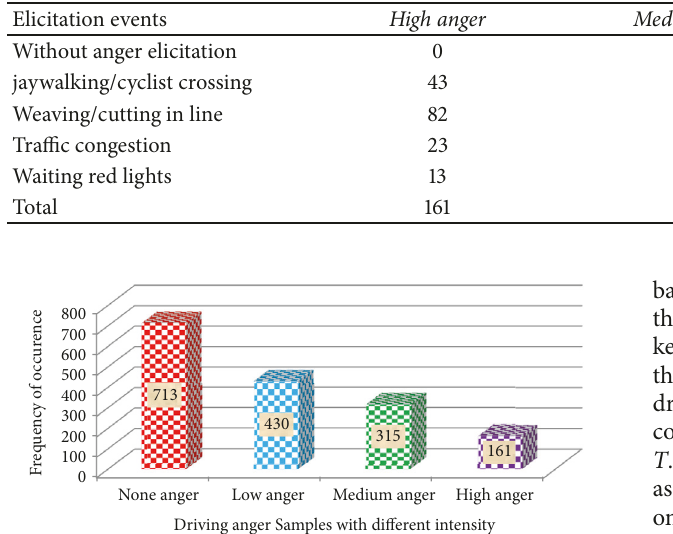
Table 3: The times of anger states triggered by the specific stimulation events.